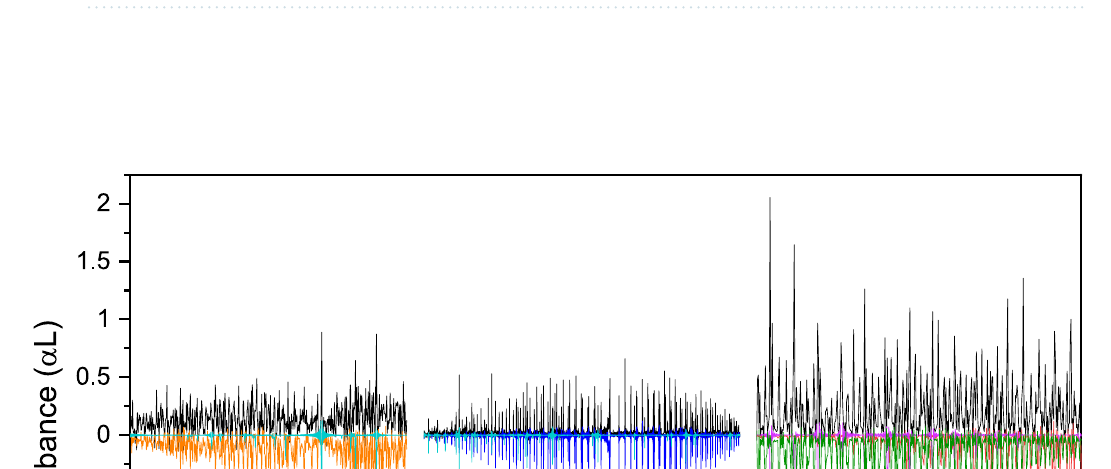
Figure 4. Retrieved concentrations of CO 2 for various dilutions of CO 2 in N 2 , along with a linear fit to demonstrate the linear response of the system. The error provided is the relative difference between the applied and retrieved concentration.